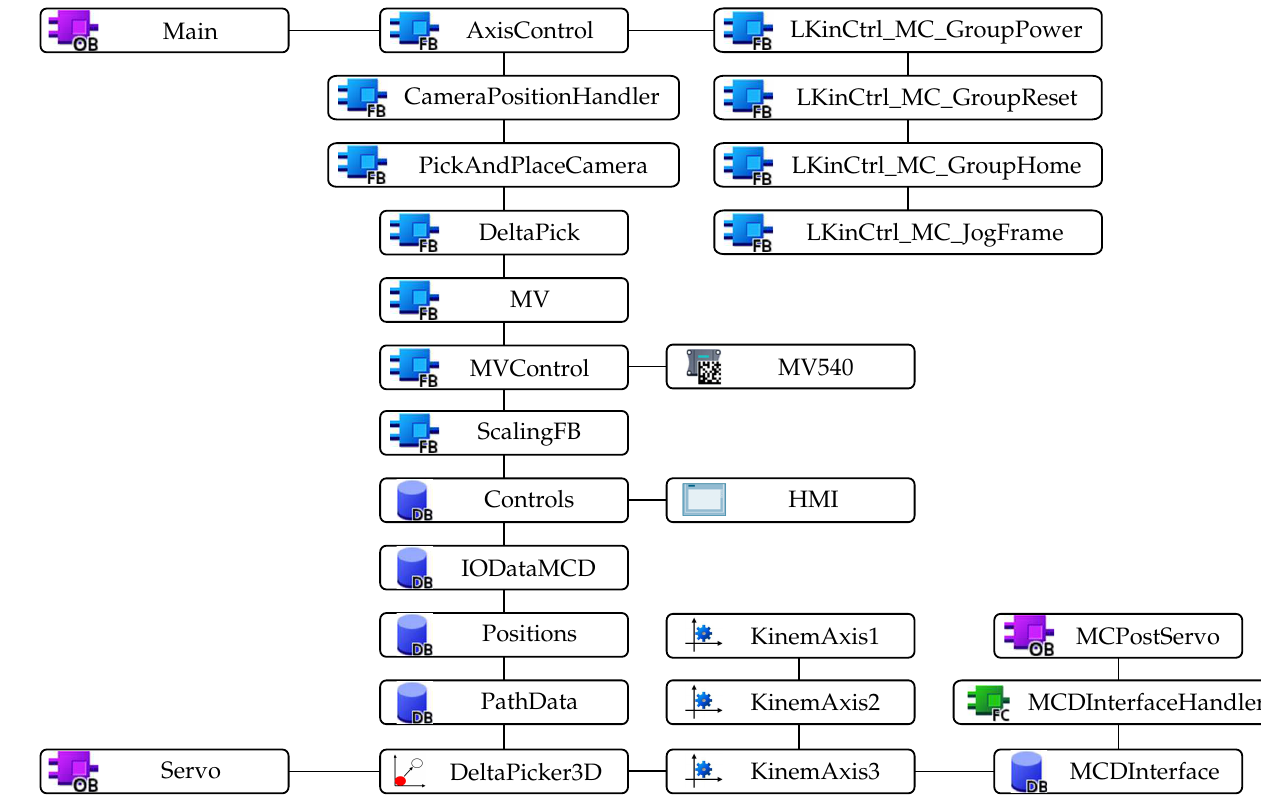
Figure 10. Call structure of the PLC program using HVC. Note: OB – organization block, FB – function block, DB – data